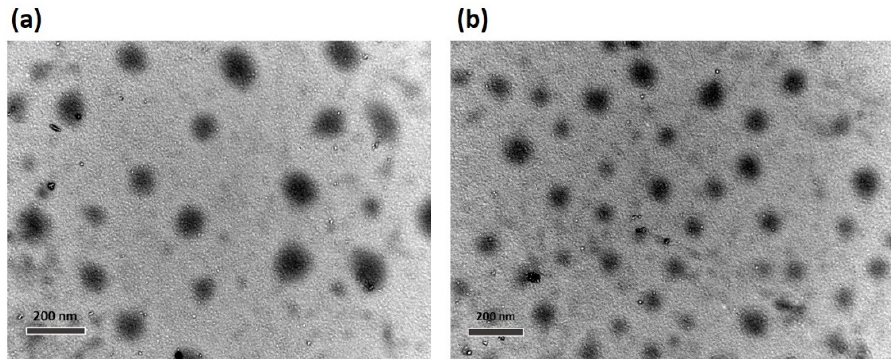
Figure 6. TEM images of ( a ) non-CCL micelles and ( b ) CCL micelles.